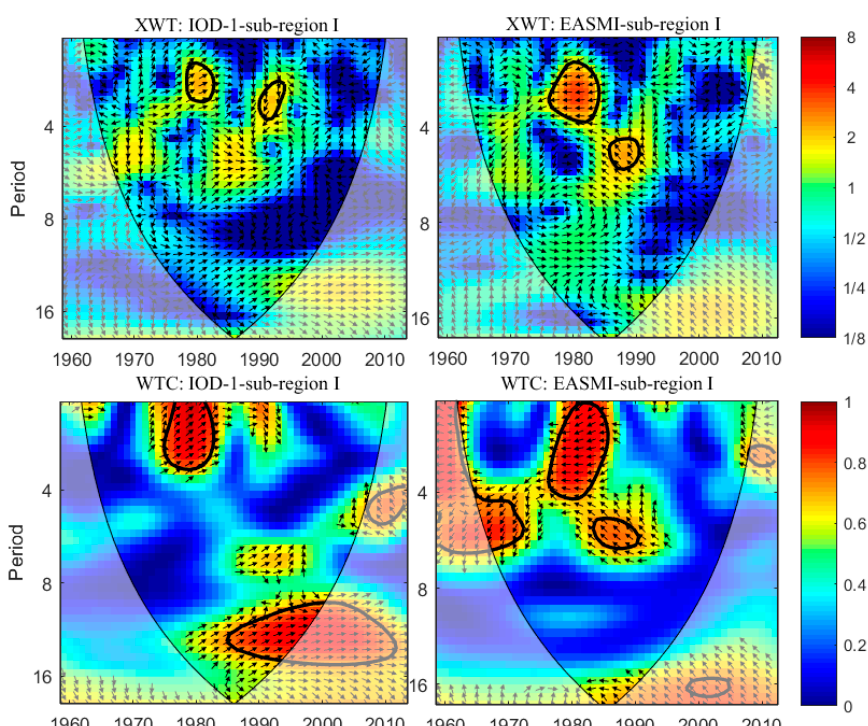
Figure 9. The wavelet cross spectrum (XWT) and wavelet condensation spectrum (WTC) of climate indices and summer precipitation of sub-regions. The 95% significance level against red noise is shown as a thick contour. The relative phase relationship is shown as arrows (with in–phase pointing right, anti–phase pointing left, and climate index leading precipitation by 90° pointing straight down).